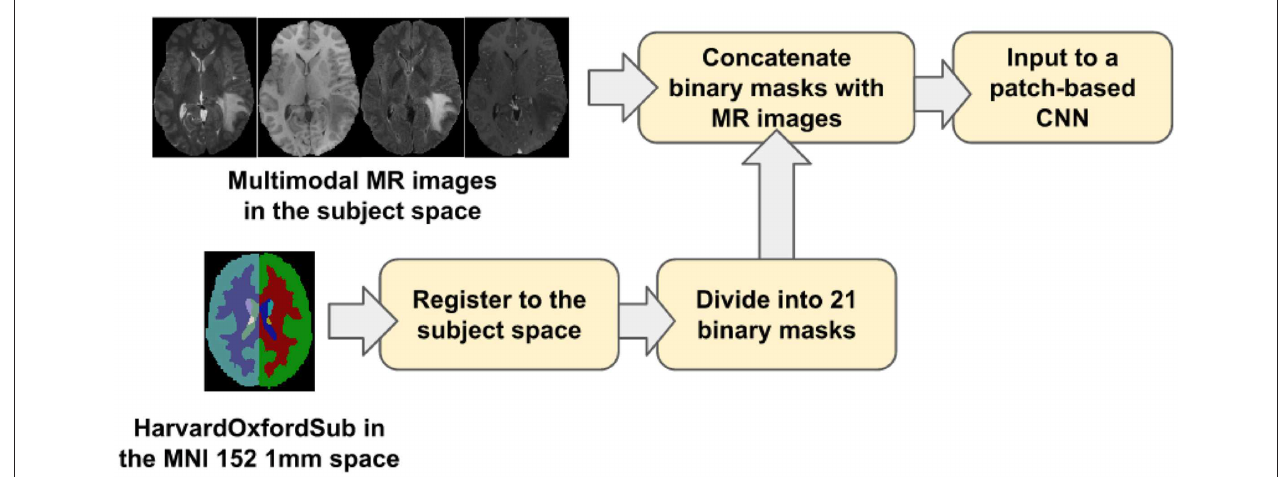
FIGURE 4 | The proposed location information fusion method for brain tumor segmentation using a patch-based convolutional neural network.